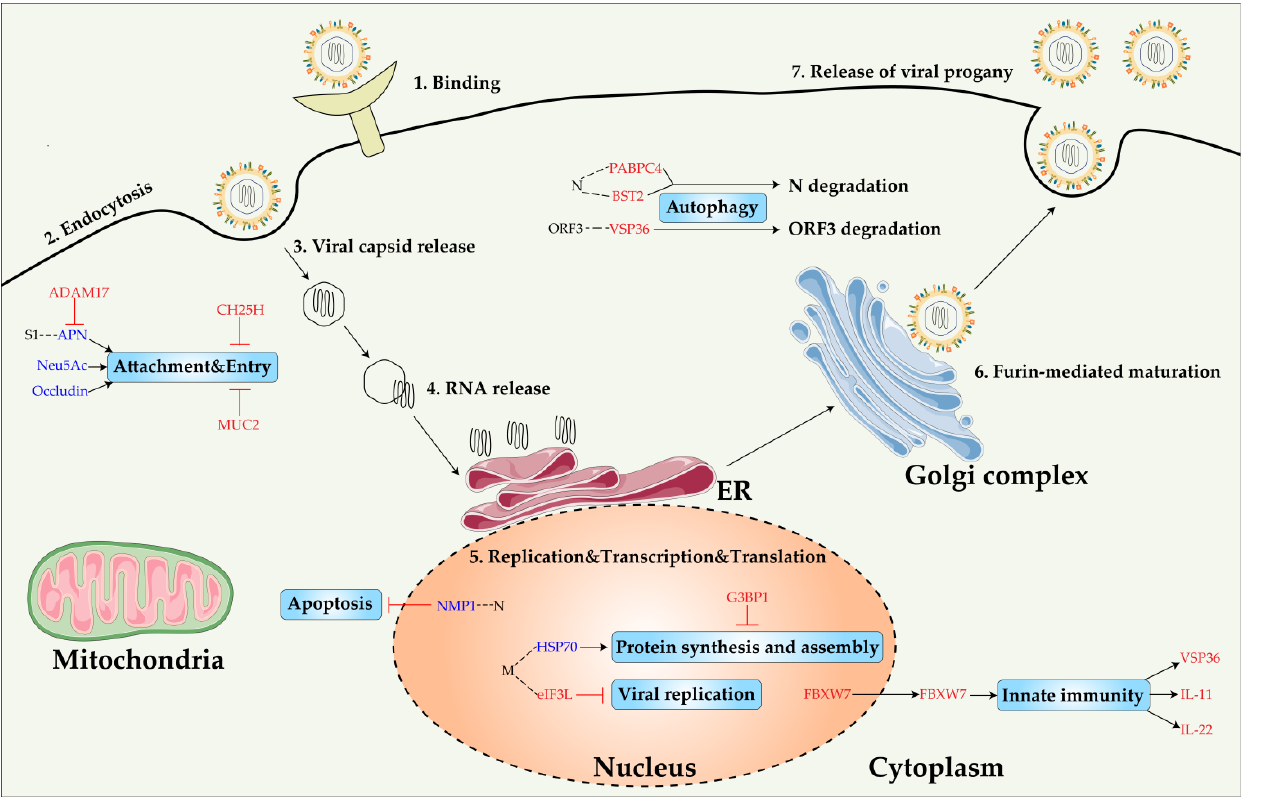
Figure 4. Schematic illustration of PEDV infection in host cells and the role of pro/antiviral host factors in PEDV replication. There are four main stages in the PEDV life cycle: attachment, entry, replication, and release. Interaction of host proteins with PEDV proteins is indicated by dotted lines; proviral host factors are indicated in blue text; antiviral host factors are indicated in red text; downstream activation is indicated by black arrows; inhibition or degradation of target genes is indicated by red lines ending in dashes.